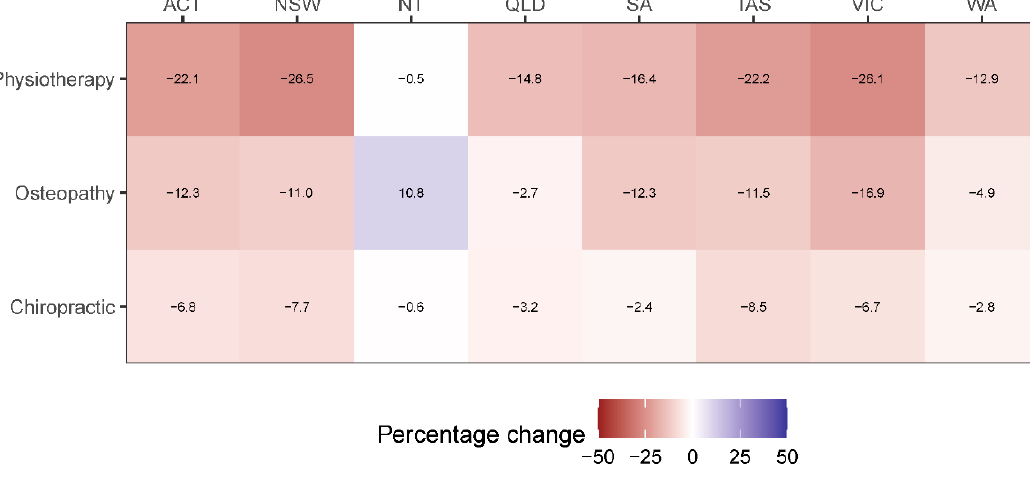
Figure 3. Heatmap of the estimated mean percentage error in number of services provided by each manual therapy profession during the first half of 2020 across Australian states and territories.